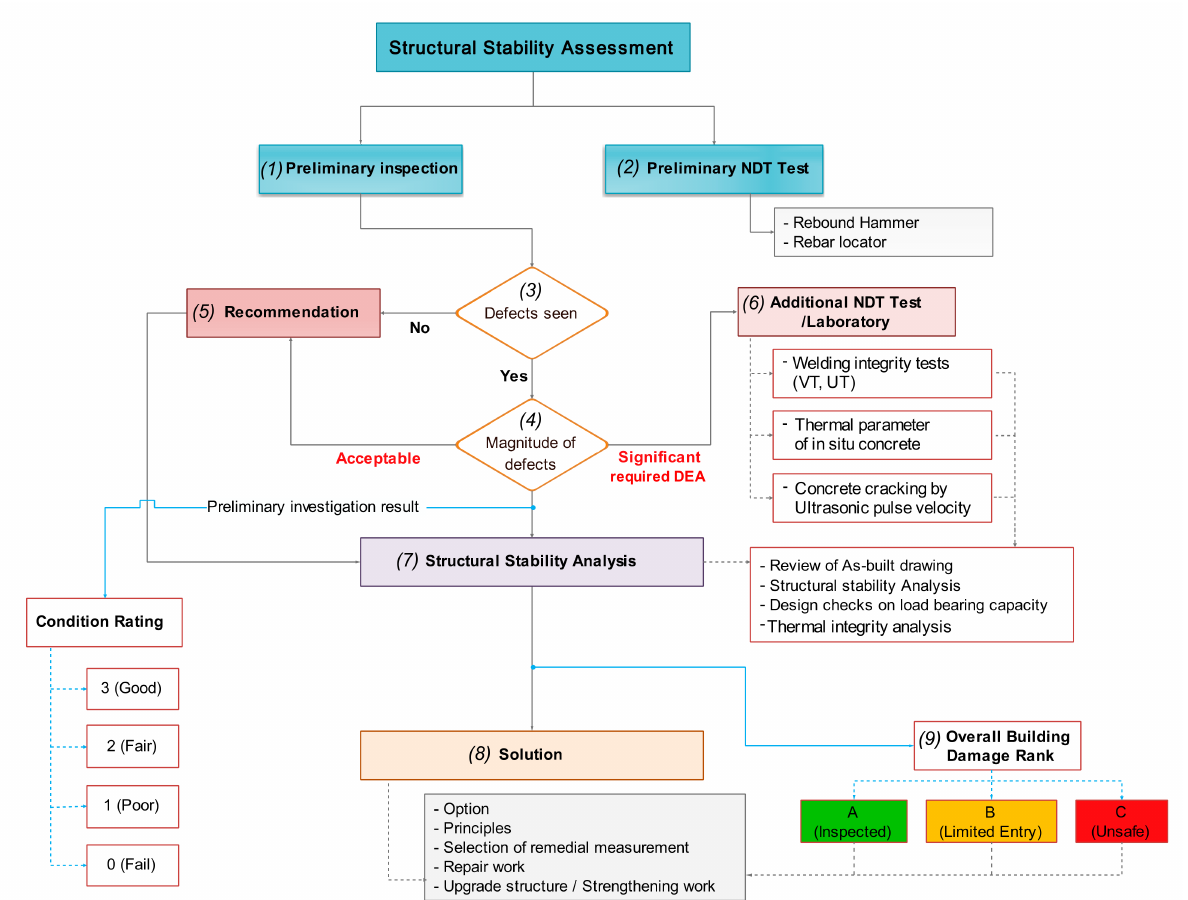
Figure 3. Flowchart of work in Phase 1 (adapted from Imjai and Tungsanga